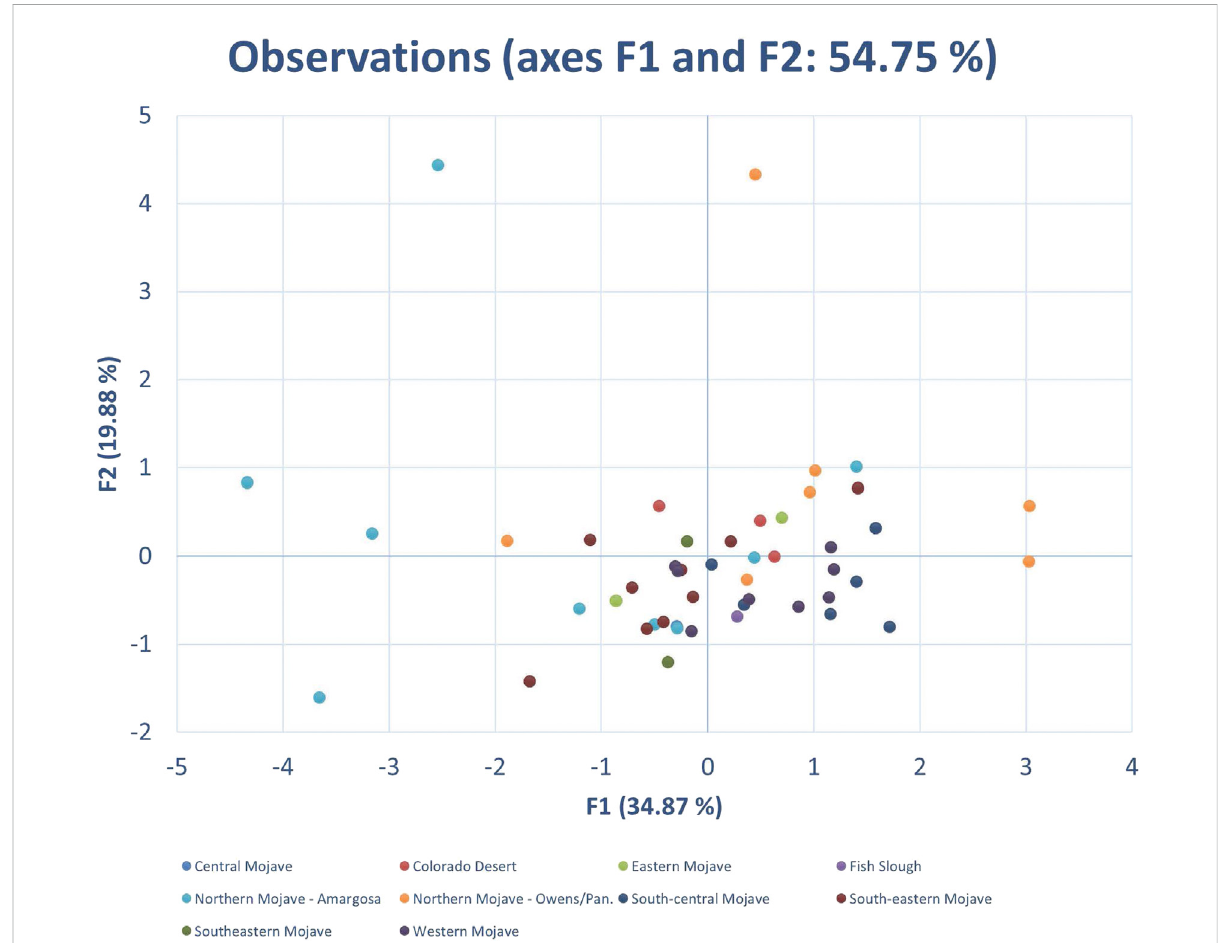
FIGURE 3 PCA biplot of F1 and F2 for ecohydrological dataset of California Desert springs with designated ecoregion color coded as